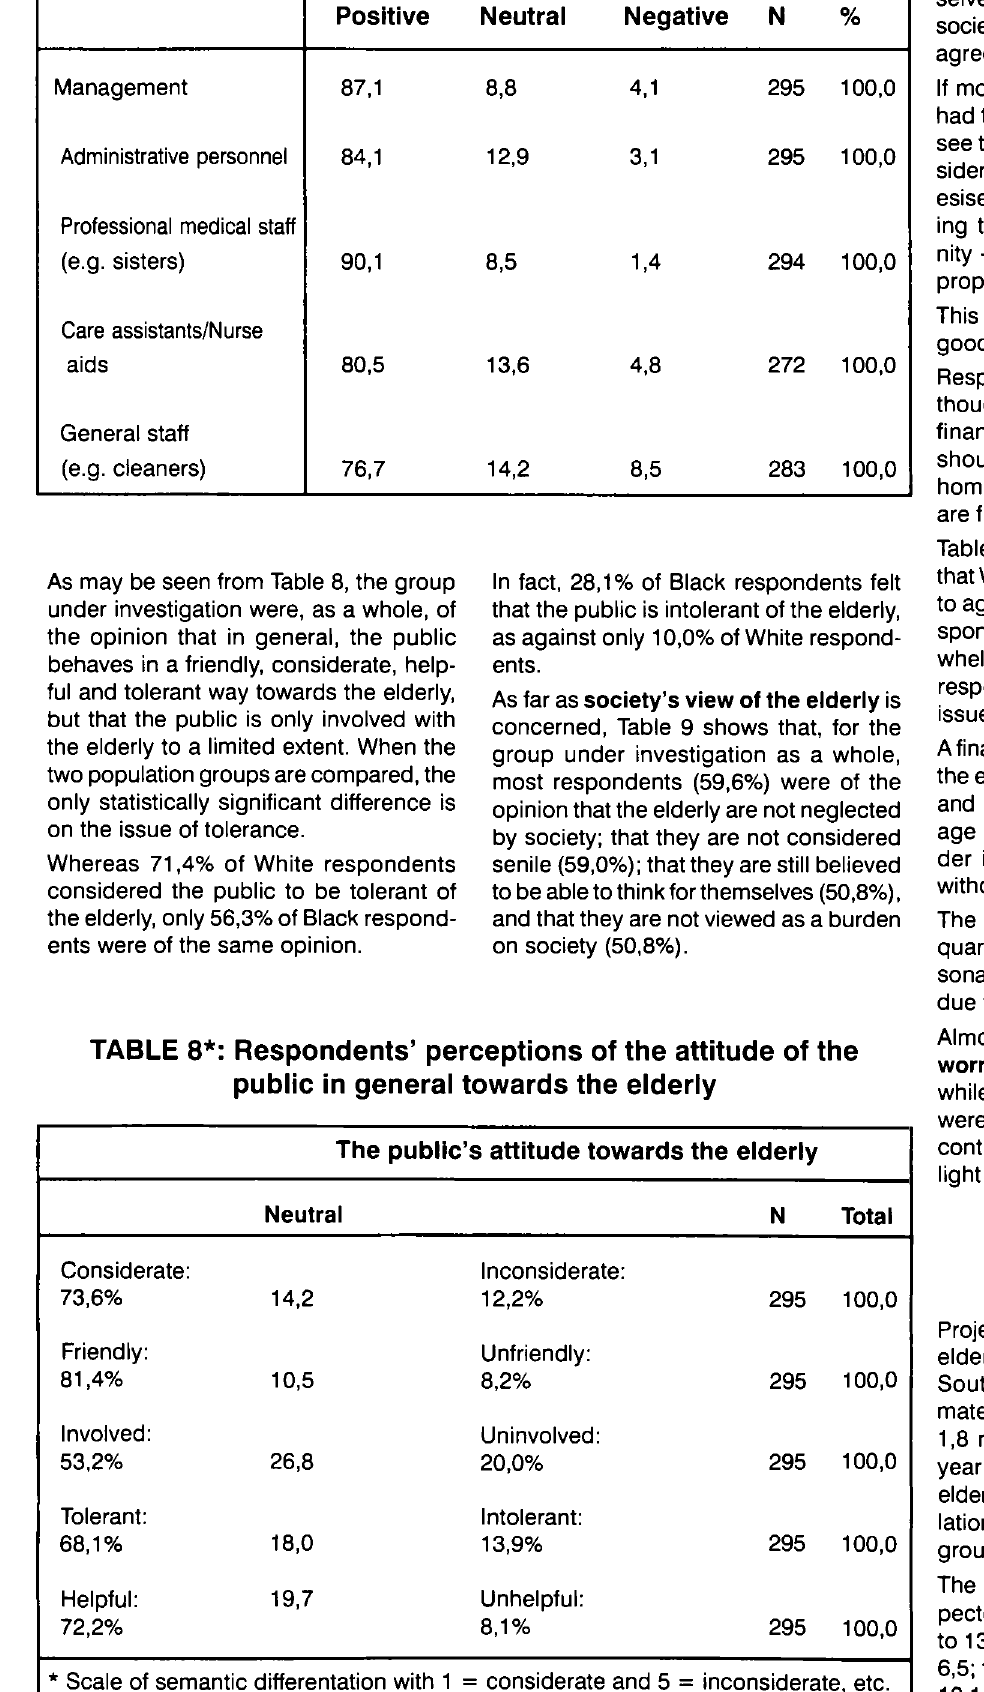
TABLE 7: Respondents’ perceptions of the staffs’ attitude towards residents Staff